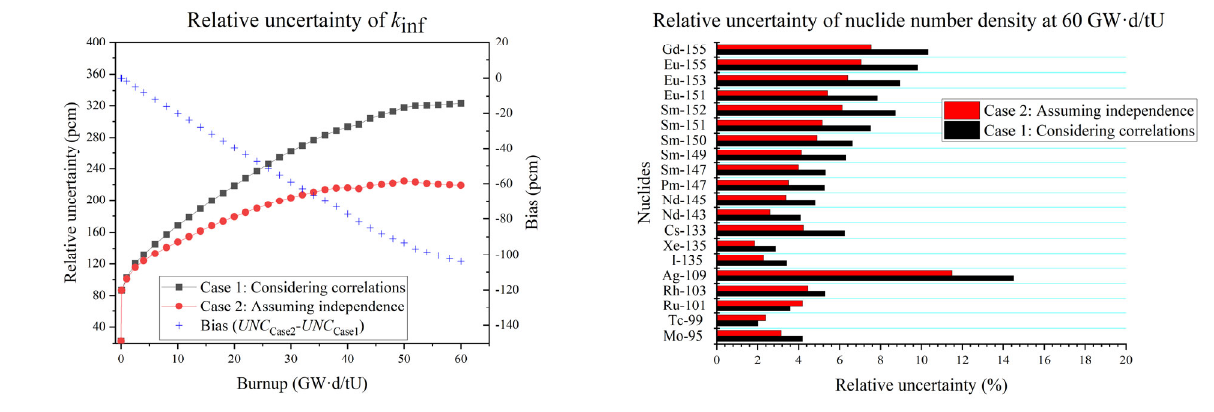
Fig.5. Uncertainty results of the TMI-1 problem for influence of correlations among fissioning